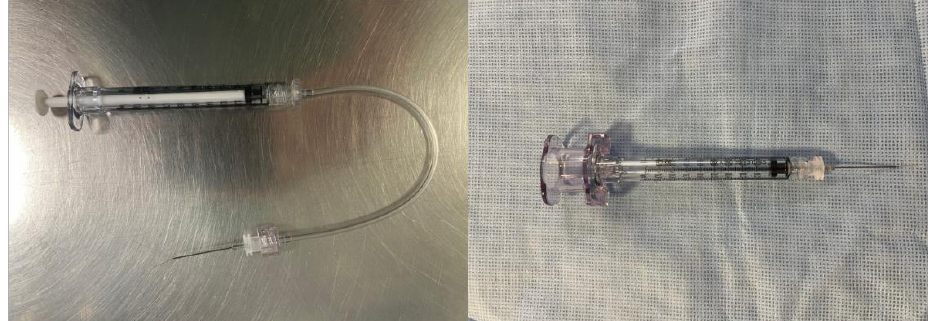
Figure 6. Left image shows the injection syringe and the high pressure extension tube when the injection is performed by two surgeons; when purging the treatment fluid there is loss of treatment in the extension tube. Right image shows the single-surgeon foot-pedal-controlled automated injection system using the viscous fluid injection mode of the vitrectomy system. MicroDose Injection Device (MedOne, Sarasota, FL, USA).